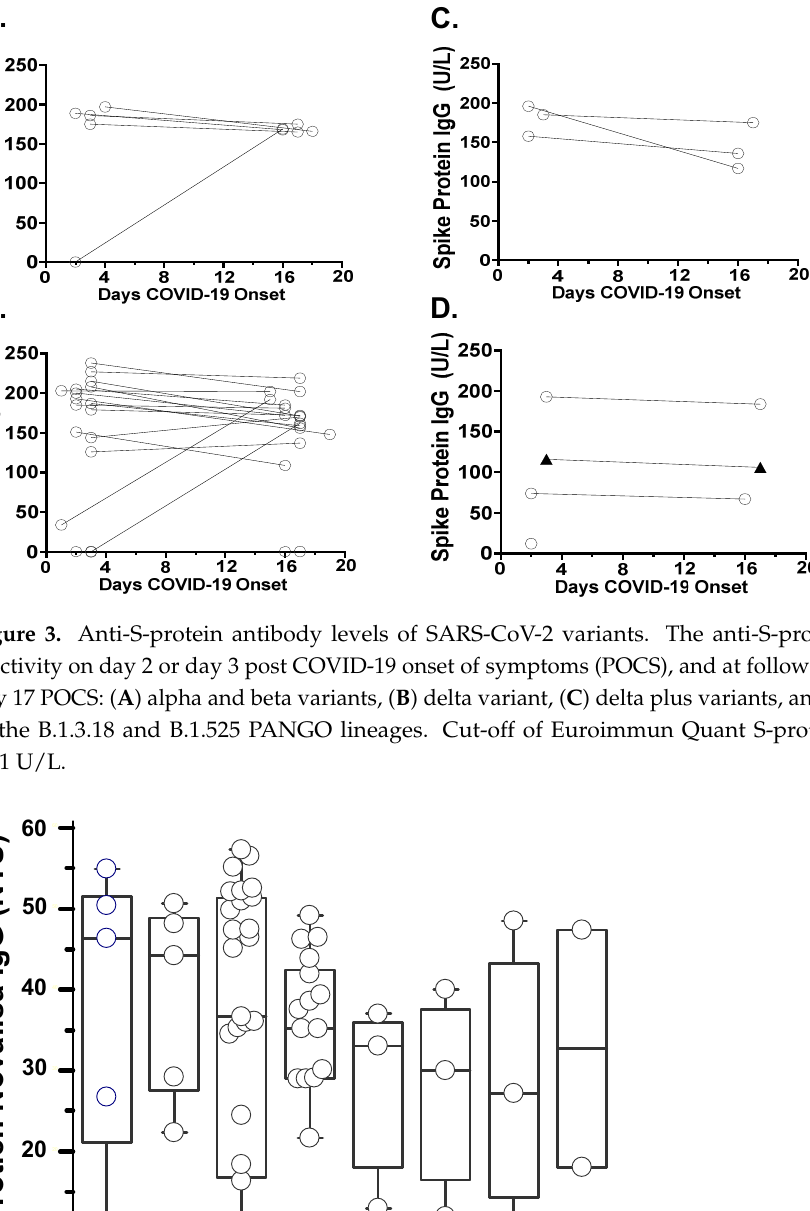
delta variants (Figure 3B). The anti-S-protein IgA in the cases of alpha or beta variants of group 1 show a trend for higher levels than anti-S-protein IgA levels of the delta variants in group 2 (Table 1).